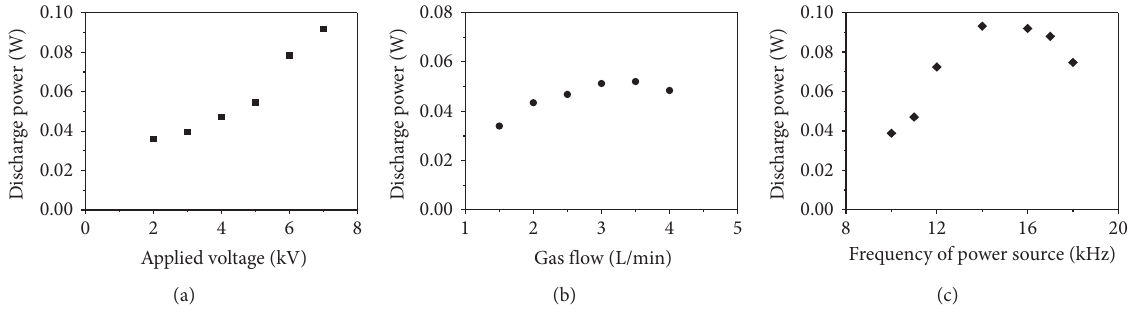
Figure 5: Effects of (a) applied voltage, (b) He gas flow rate, and (c) applied frequency on the discharge